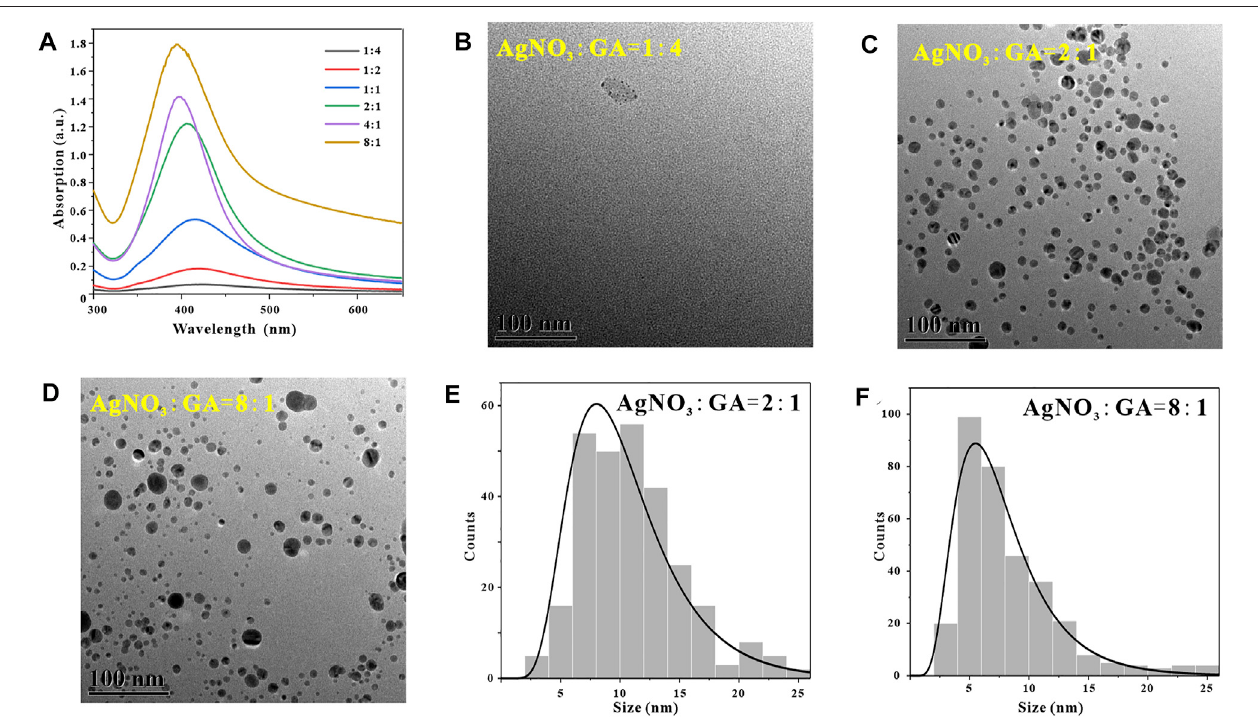
FIGURE 6 | Optimization of reaction material ratio, UV-vis spectra of GO-AgNPs under different reaction material ratio conditions (A) , TEM image of GO-AgNPs at reaction material ratio M